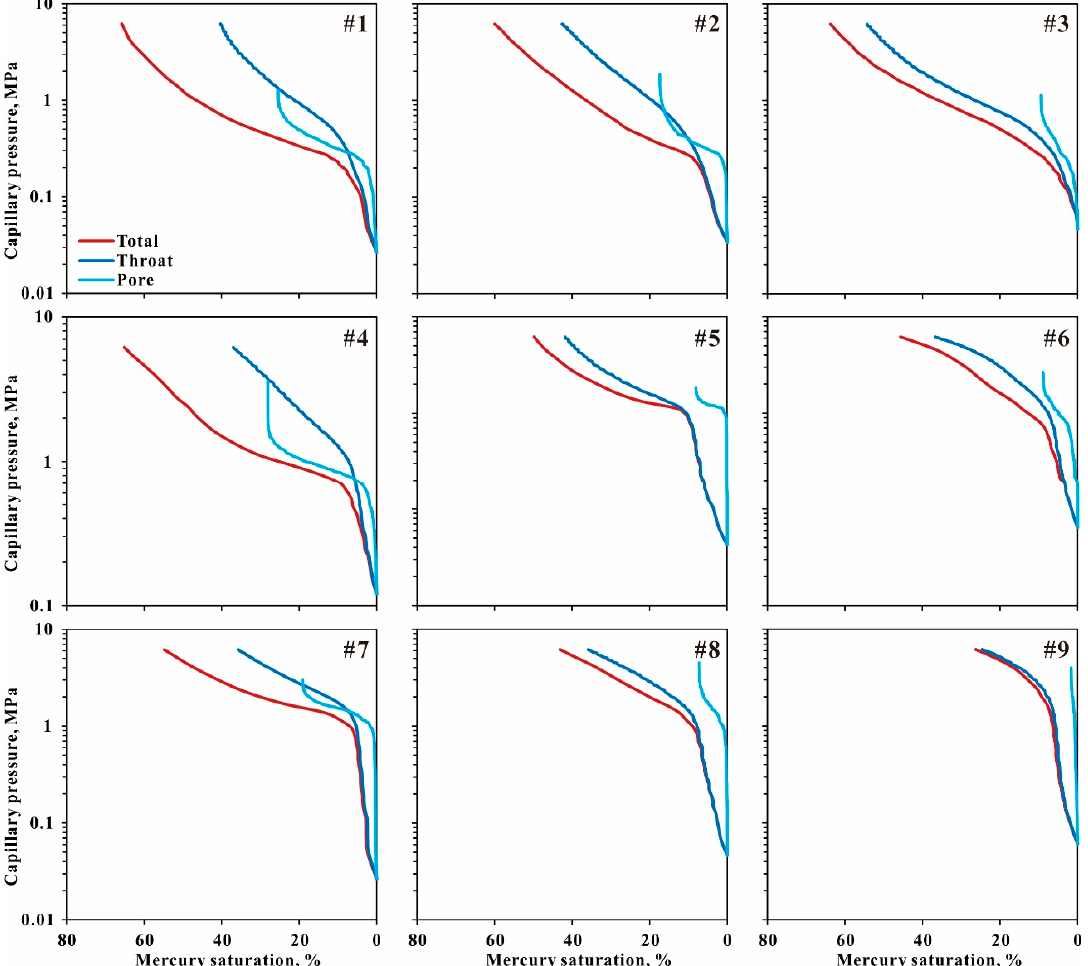
Figure 7. RMIP curves of total (pores + throats), pores and throats for the studied tight rock samples in the Xujiaweizi Rift.